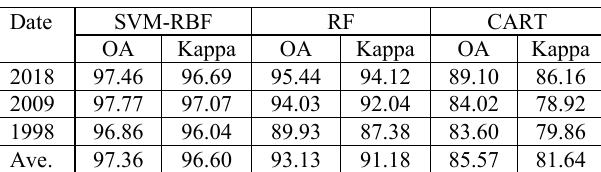
Table 8. Transferability analysis of machine learning algorithms